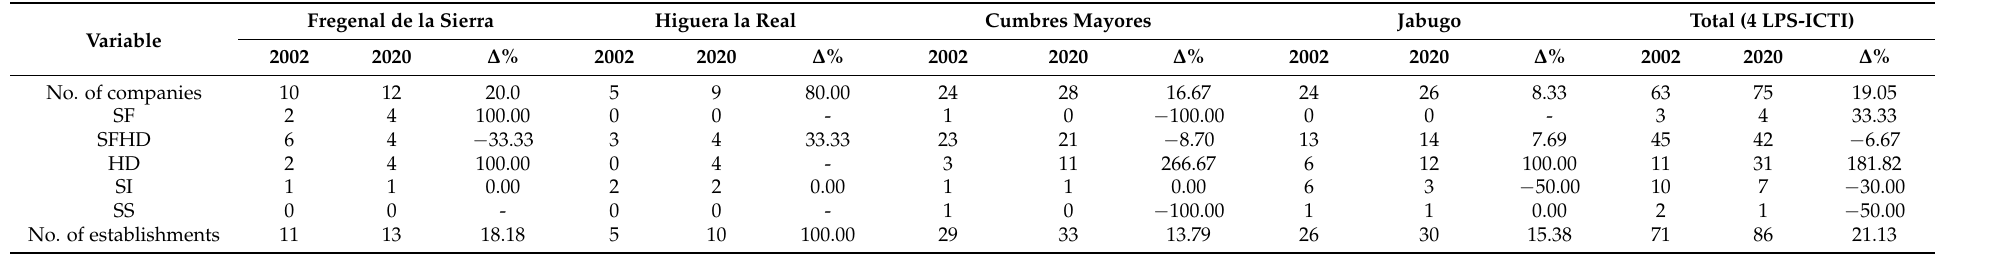
Table 3. Variation in the industrial and business structure in the 4 LPS-IPTIs (2002–2020).